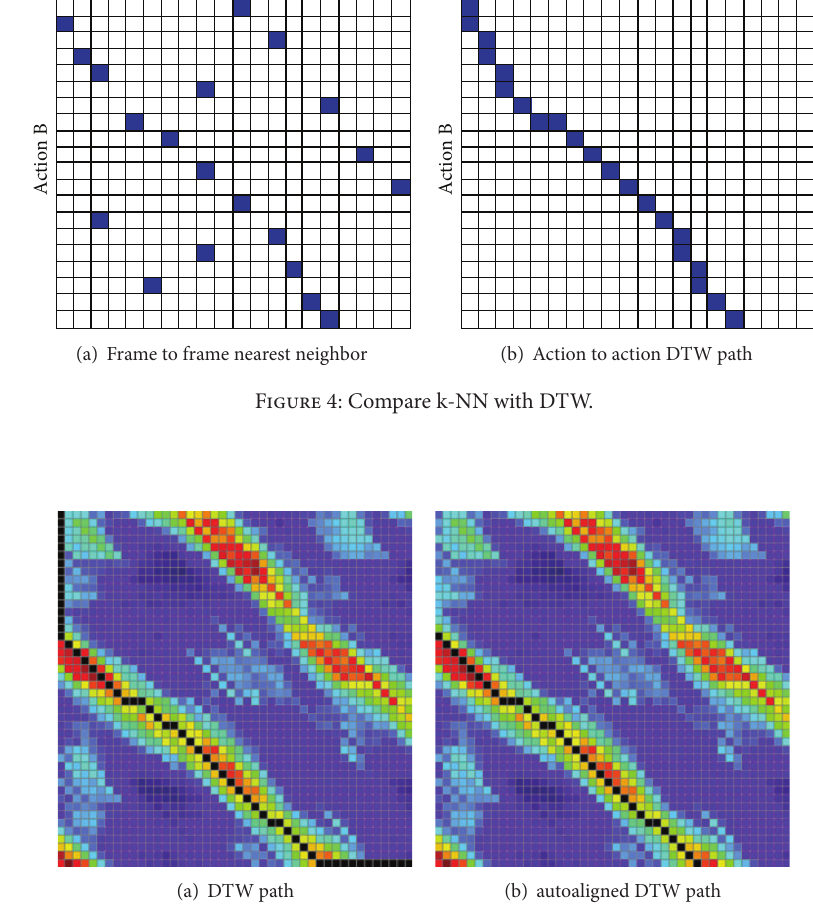
Figure 5: DTW matching path of two actions. (a) Original DTW algorithm result. (b) Autoaligned DTW path shows matching start point and matching end